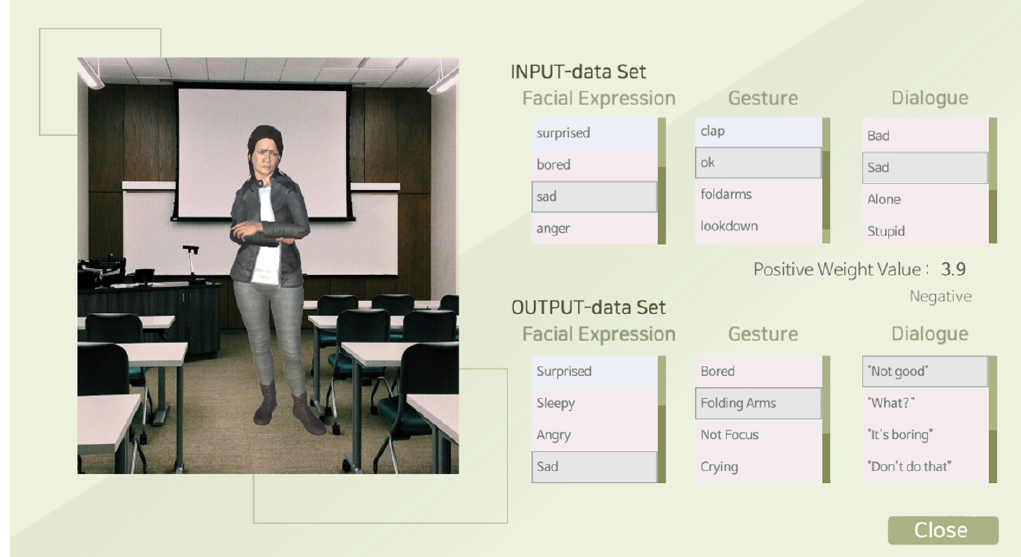
Figure 3. The virtual human editing toolkit: creating the virtual human’s response with input datasets to perceive the user’s surroundings (e.g., facial expression, gesture, and dialogue). The virtual human can recognize users’ situations, presenting an optimal response to users by context aware- ness.